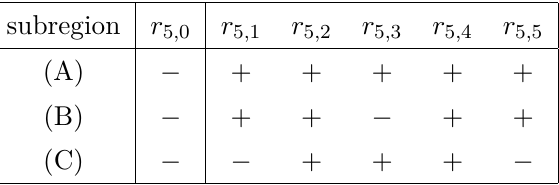
Table 2 . Signs of the leading singularities (3.12) in different kinematic regions.